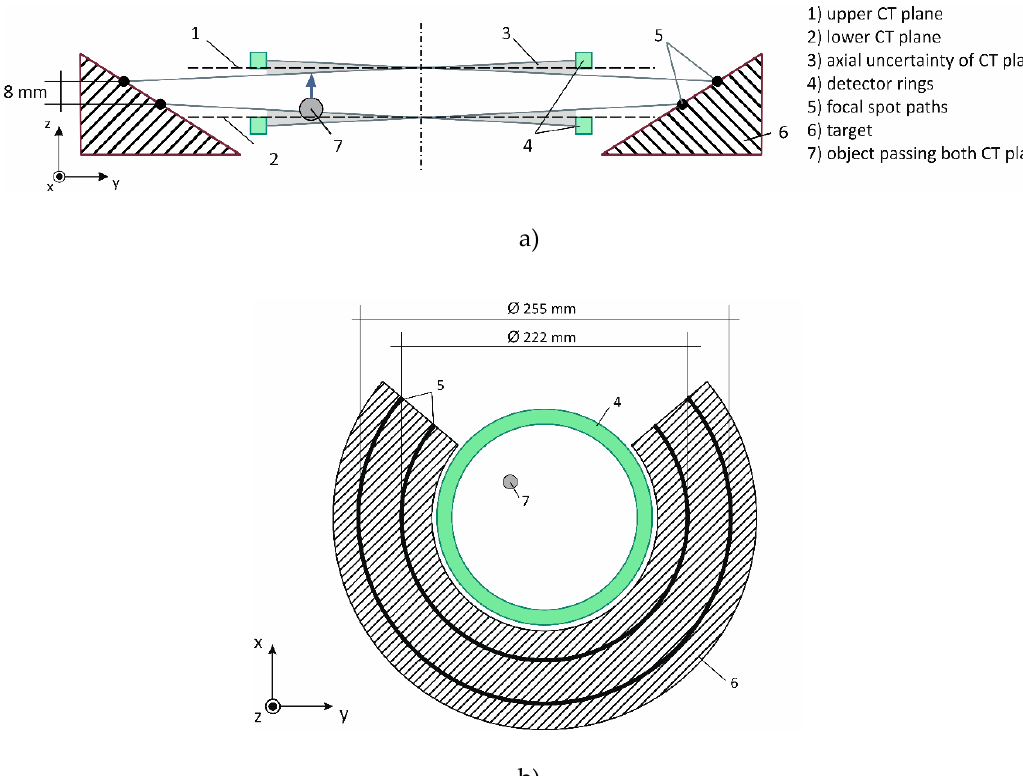
Figure 2. Schematic axial cut view of the ultrafast electron beam X-ray CT arrangement of tungsten target and detector rings: ( a ) Side view ( b ) top view. The focal spot paths usually have a vertical distance of approximately 8 mm. For more details, see [26].